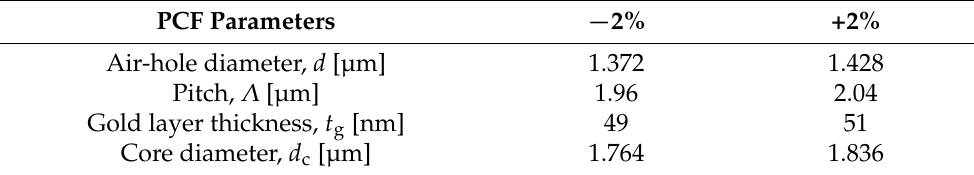
Table 2. Two-level Four Parameters ( ± 2% variations) and their values for DoE Factorial Analysis. PCF Parameters − 2% +2% Air-hole diameter, d [µm] 1.372 1.428 Pitch, Λ [µm] 1.96 2.04 Gold layer thickness, t g [nm] 49 51 Core diameter, d c [µm] 1.764